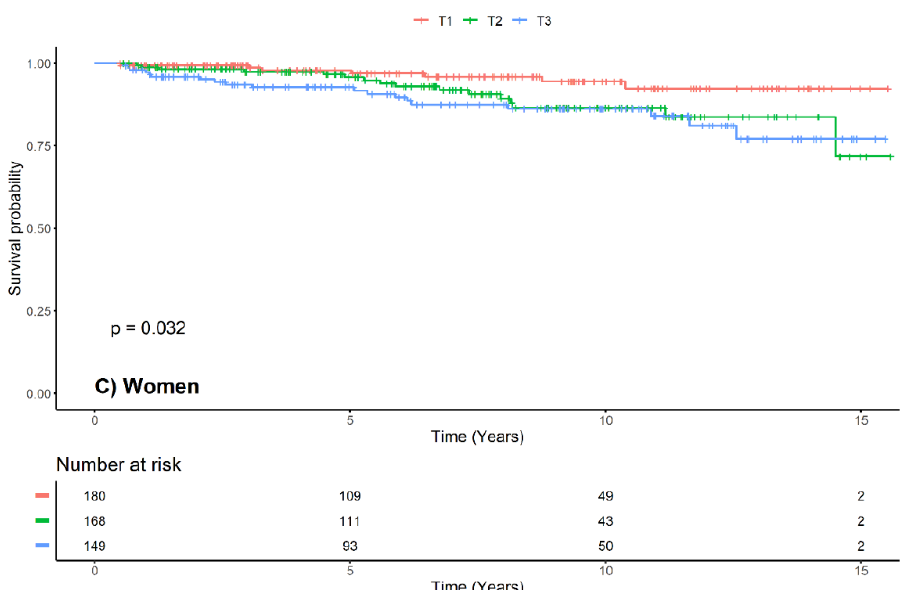
Figure 5. Kaplan–Meier survival curve with log-rank test between progression of LN and serum uric acid by sex. Kaplan–Meier survival curve for total patients ( A ), men ( B ) and women ( C ). Hyperuricemia was associated with progression of LN in total and women but not in men. The range of serum uric acid of terciles is 3.8 ± 0.8 mg / dL in T1, 5.6 ± 0.5 mg / dL in T2 and 8.3 ± 1.9 mg / dL in T3 respectively. T1, tercile 1; T2, tercile 2; T3, tercile 3.